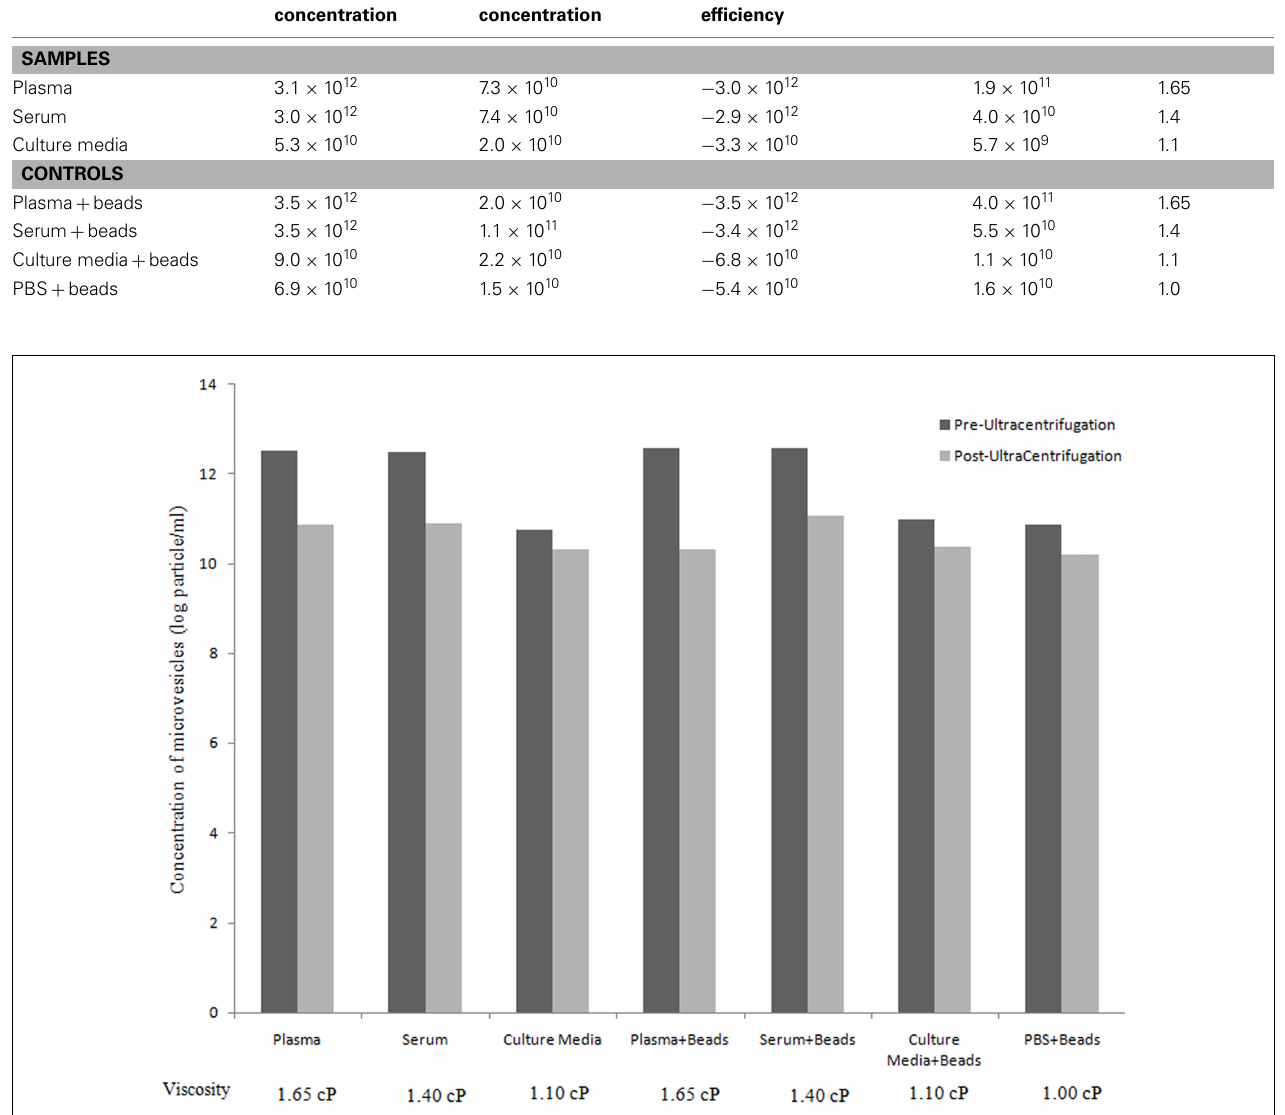
Table 1 | Evaluation of microvesicles/microparticles concentration (particles/ml) and viscosity before and after ultracentrifugation. Biofluids (particles/ml)